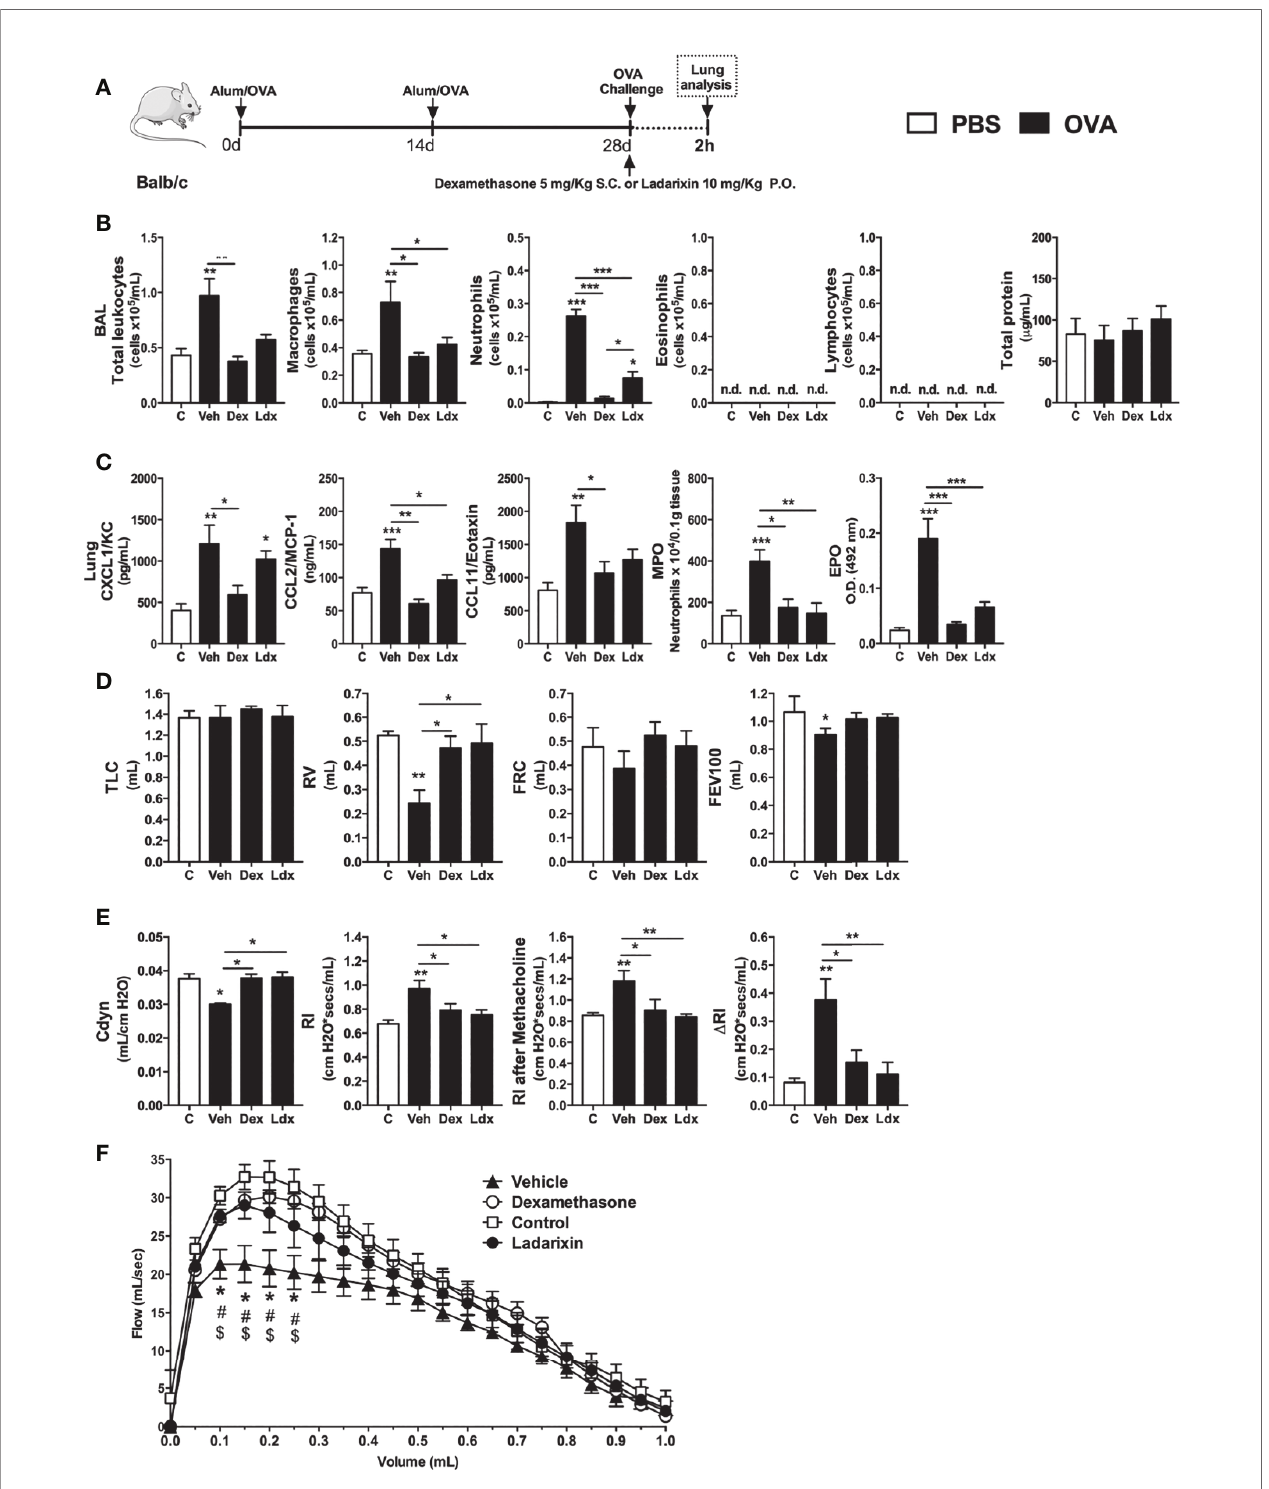
FIGURE 3 | Ladarixin treatment reduces Th2 allergic airway in fl ammation induced by a single OVA challenge. In fl ammatory parameters were evaluated 2 h after a single challenge with OVA. (A) Schematic representation of the experimental design. (B) Assessment of leukocyte in fl ux and blood leakage into airways. (C) Chemokine levels, MPO and EPO activity assay in lung tissue. Assessment of pulmonary mechanics for (D) lung volumes, (E) compliance and lung resistance. (F) Flow-Volume curve. n = 8 for each group, * for P < 0.05; ** for P < 0.01 and *** for p < 0.001. TLC, total lung capacity; RV, residual volume; FRC, functional residual capacity; FEV100, forced expiratory volume in 100 ms; Cdyn, dynamic compliance; Rl, lung resistance; D Rl, methacholine-evoked hyperresponsiveness. # differences between Dexamethasone vs Vehicle. $ differences between Ladarixin vs